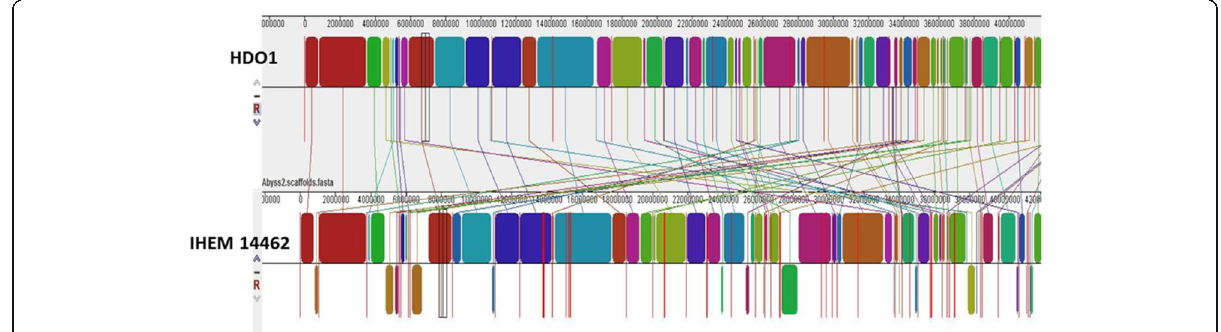
Fig. 4 MAUVE [62] alignment of draft genome sequence of HDO1 strain and draft genome sequence of IHEM 14462 strain. The figure represents the locally contiguous blocks (LCBs) that both sequences share, connected by lines to show their positions in the genomes. At the top the sequence of HDO1 strain is visualized and at the bottom the re-ordered sequence of the IHEM 14462 strain appears [23]. Blocks that are shown below indicate regions that have the reverse sequence related to the HDO1